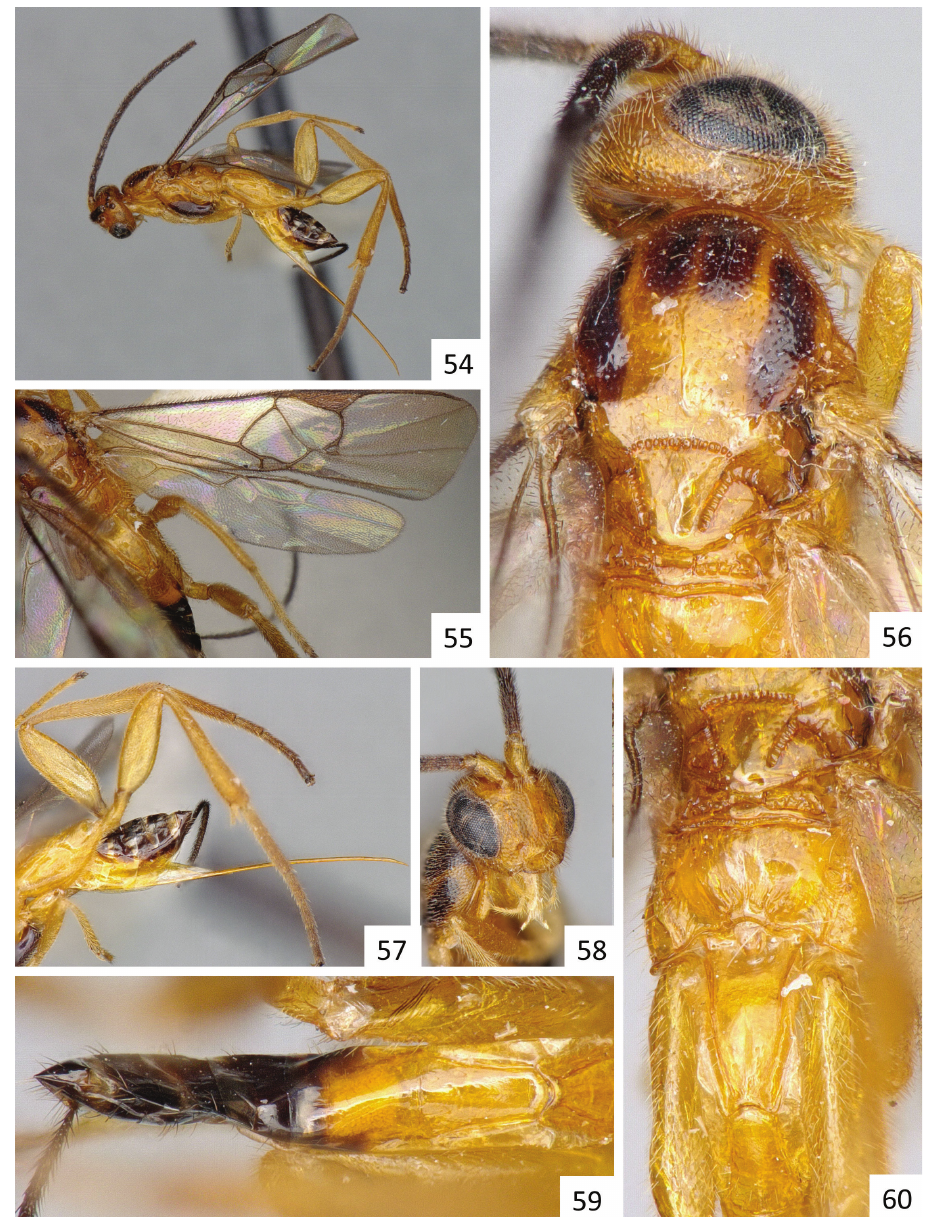
Figures 54–60. Sendaphne paranaensis , female specimen from Brazil. 54 Habitus, lateral view 55 Fore wing 56 Head and mesosoma (partially), dorsal view 57 Metasoma and legs, lateral view 58 Head, frontal view 59 Metasoma (partially), dorsal view 60 Scutellar disc, propodeum and T1-T2 (partially), dorsal